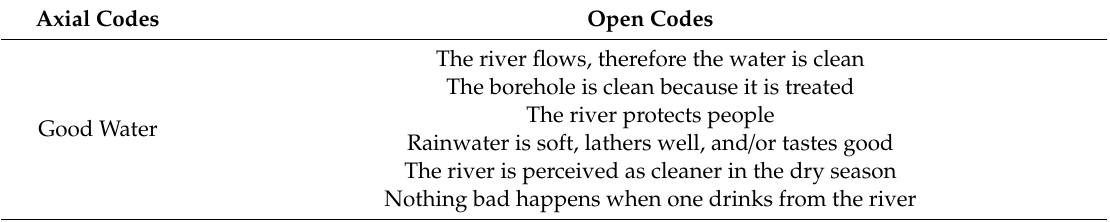
Table A2. Open Codes Grouped into Axial